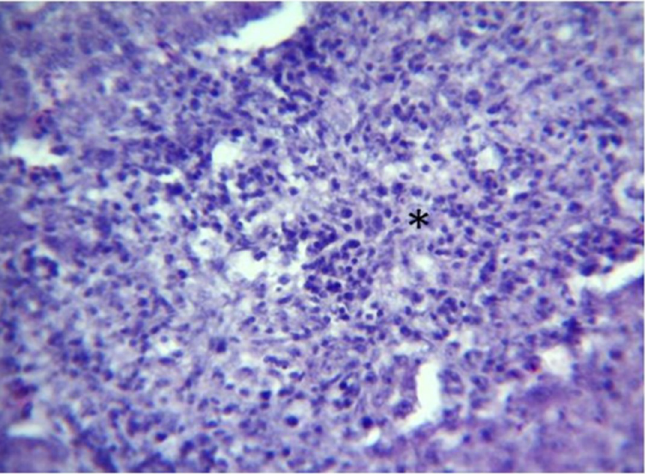
Fig 5. Liver at 6dpi (higher magnification of Fig 4)–foci of hepatic necrosis. Mixed heterophils and lymphocytes with cellular debris of necrotic hepatocytes (Asterix). H&E,